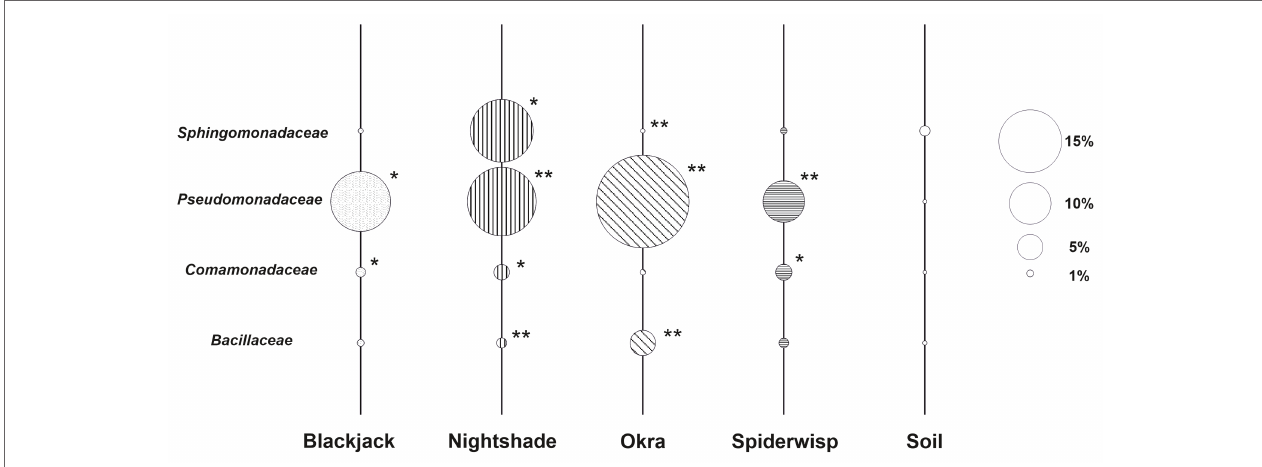
FIGURE 7 | Relative abundance of antagonistic families of bacteria associated with leafy green vegetables. The diameter of the bubble represents the abundance of each family within the microbiome of each leafy green crop and soil. Soil is used as a reference. Families, which were found to produce nematicidal VOCs in Ugandan tomatoes (Wolfgang et al., 2019) – namely Comamonadaceae and Pseudomonadaceae – are included. Asterisks indicate significant differences in relative abundance compared to soil based on LEfSe (* p ≤ 0.05; ** p ≤